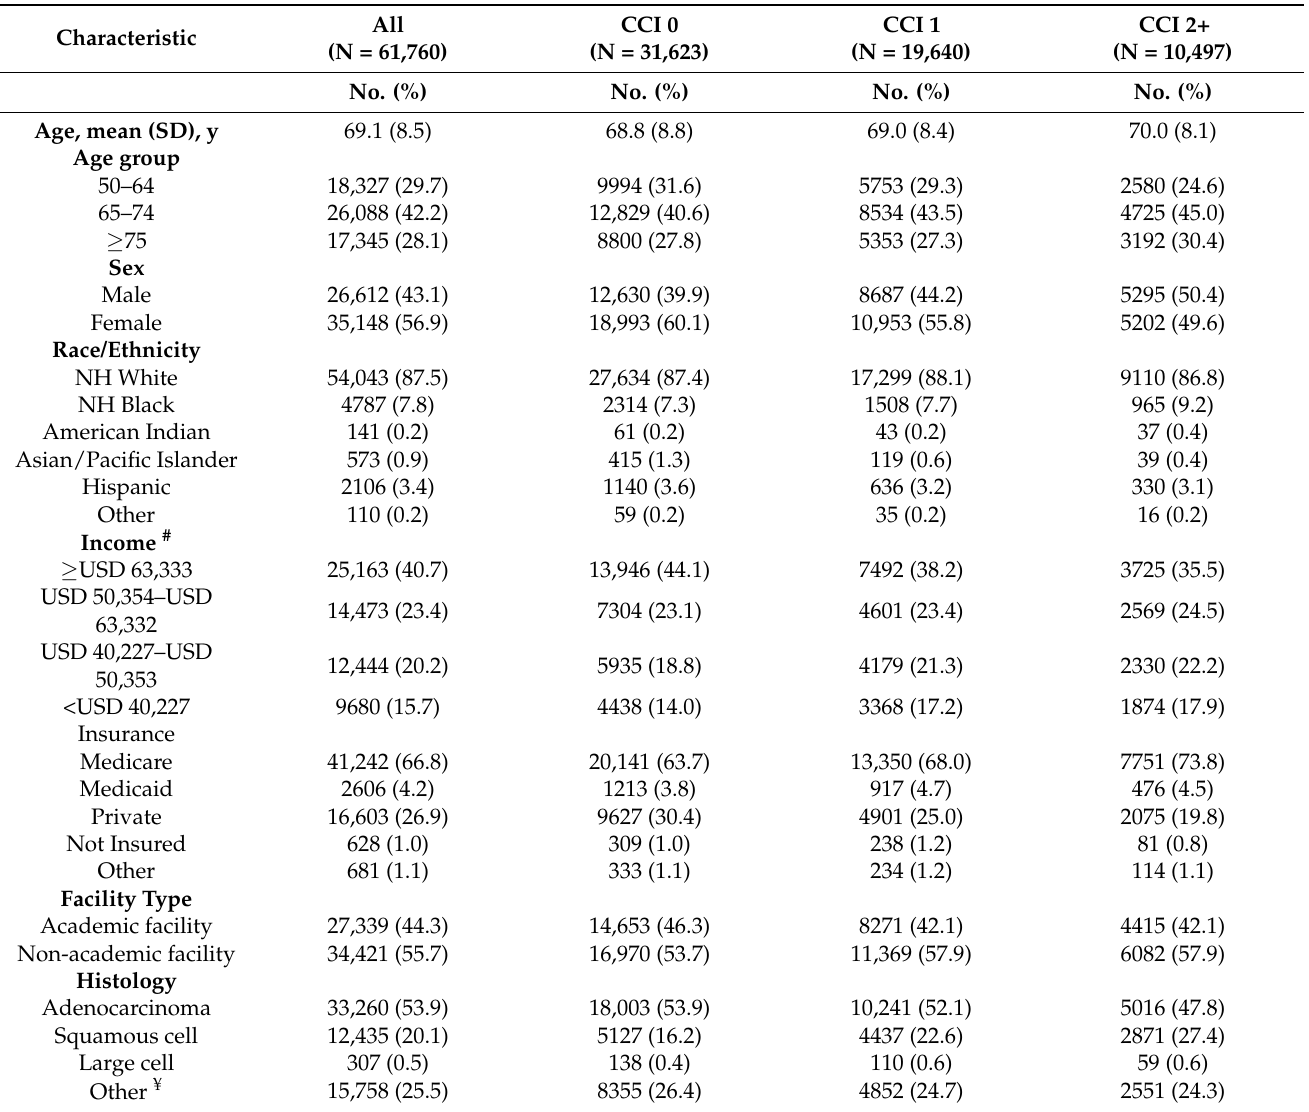
Table 1. Summary of study